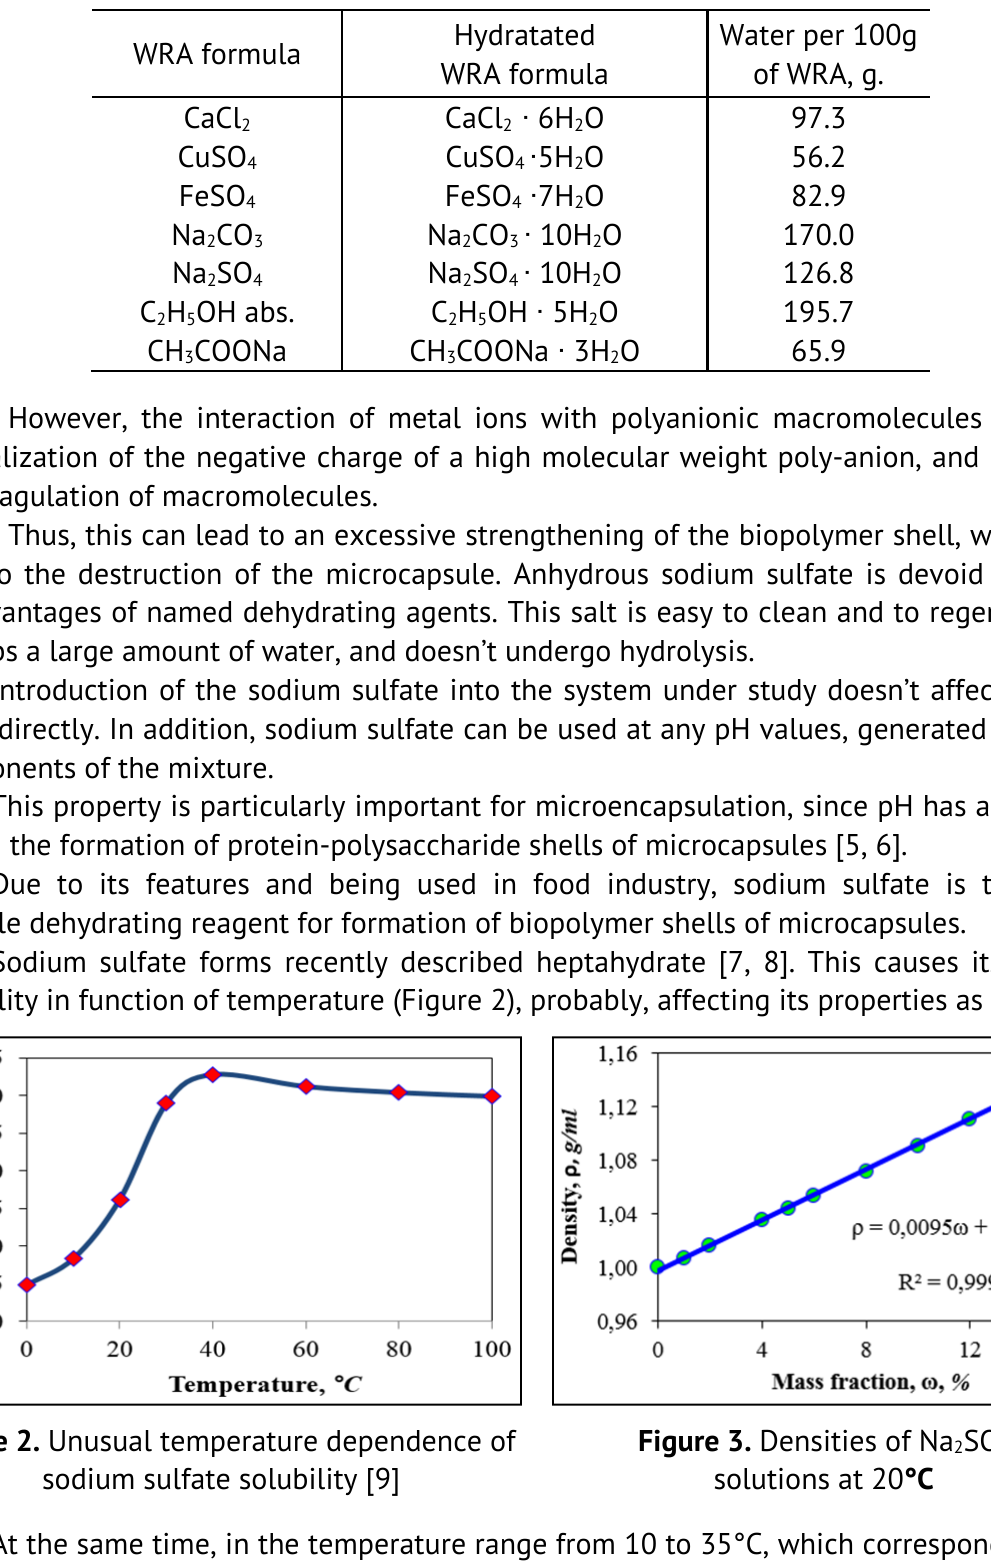
Water-absorption capacity of some common water-removing agents (WRA)